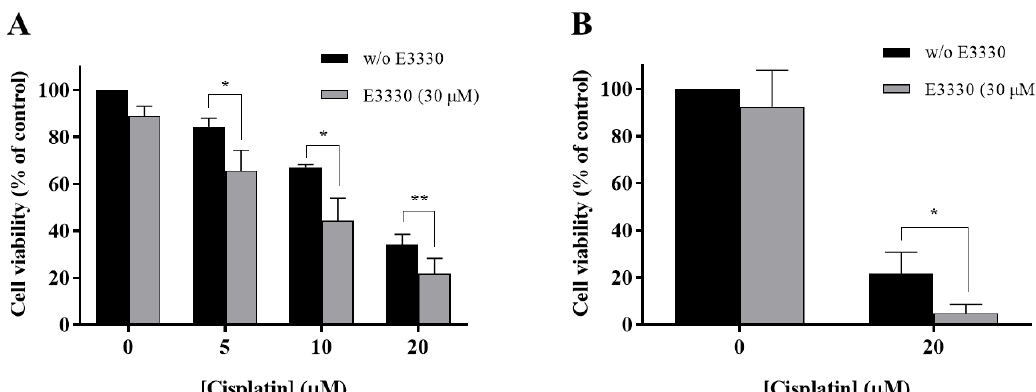
Figure 4. Impact of E3330 on the viability of H1975 cells treated with cisplatin. Cells were pre-